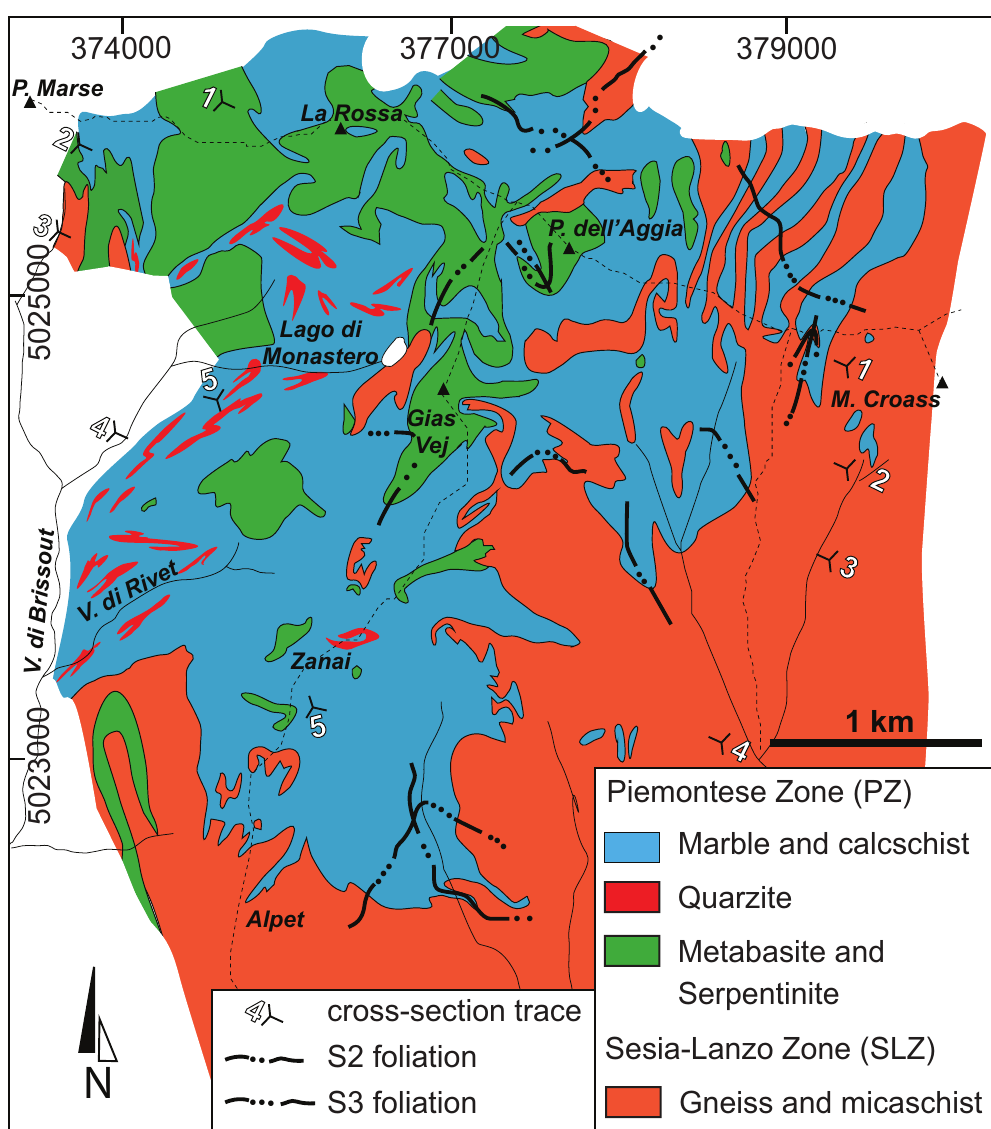
Figure 2. Interpretative geological map of Gias Vej - Lago di Monastero area modified after [13]. Coordinate system WGS 84 - UTM